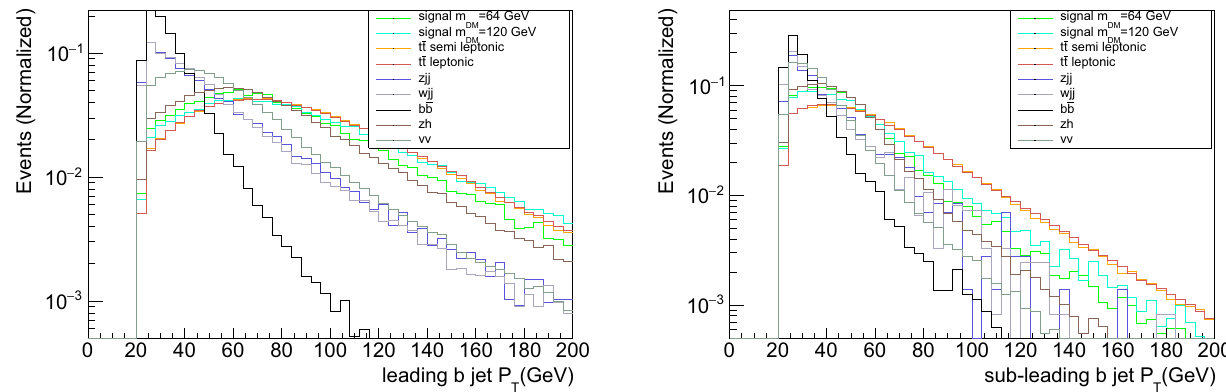
Fig. 12 Normalized distributions of the transverse momenta of the leading (left) and sub-leading (right) b -jets